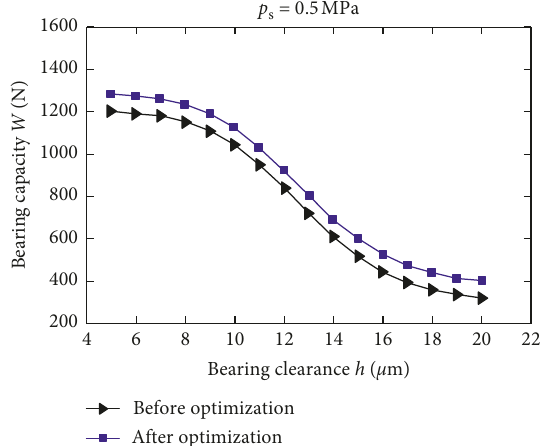
Figure 10: Comparison of bearing capacity.